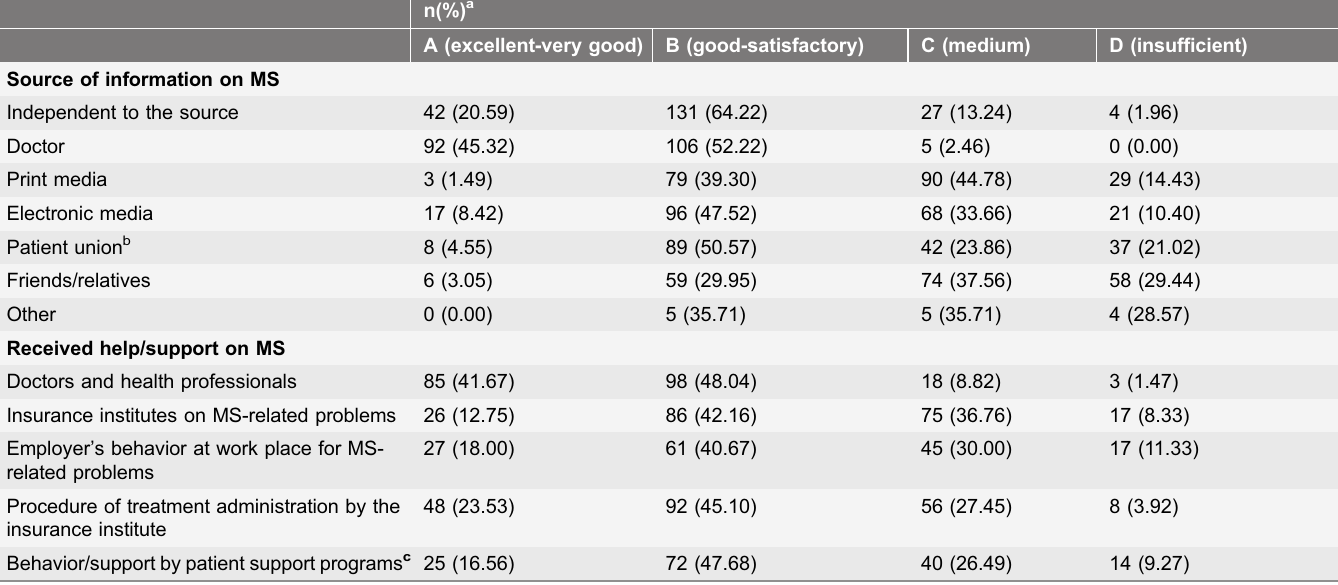
Table 4. Patient evaluation of the received information and help/support on multiple sclerosis. n(%) a A (excellent-very good) B